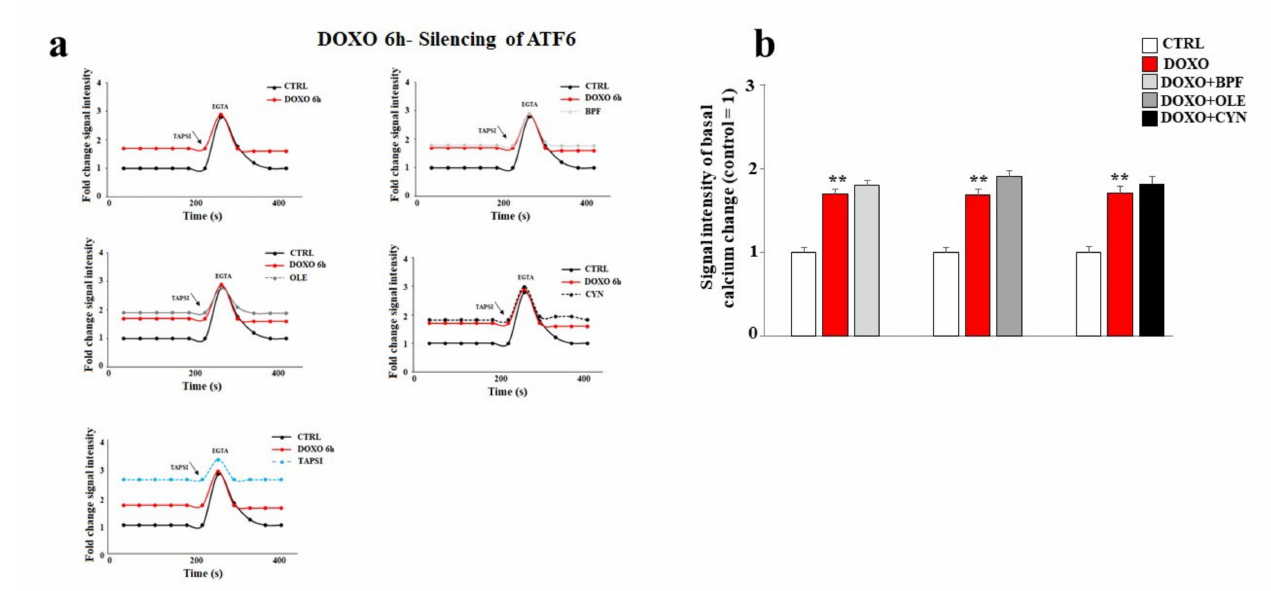
Figure 7. Measurement of the lipid content after ATF6 silencing. Following the silencing of the ATF6 protein, the cell lipid content was measured by cytometric and spectrophotometric analyses. A representative cytometric analysis of three independent experiments is shown; plot M3 represents a marker arbitrarily designed to show fluorescence variations (panel a ). The relative quantification graph was constructed by setting the control value to be equal to 1 and comparing all other values to this (panel b ). In panel b, black bars refer to the results of the cytometric analysis, while grey bars refers to the results of the spectrophotometric analysis. The values of three independent experiments are expressed as the mean ± standard deviation. *** denotes p < 0.001 vs. control; § denotes p < 0.05 vs. DOXO. The Analysis of Variance (ANOVA) was followed by the Tukey–Kramer comparison test.